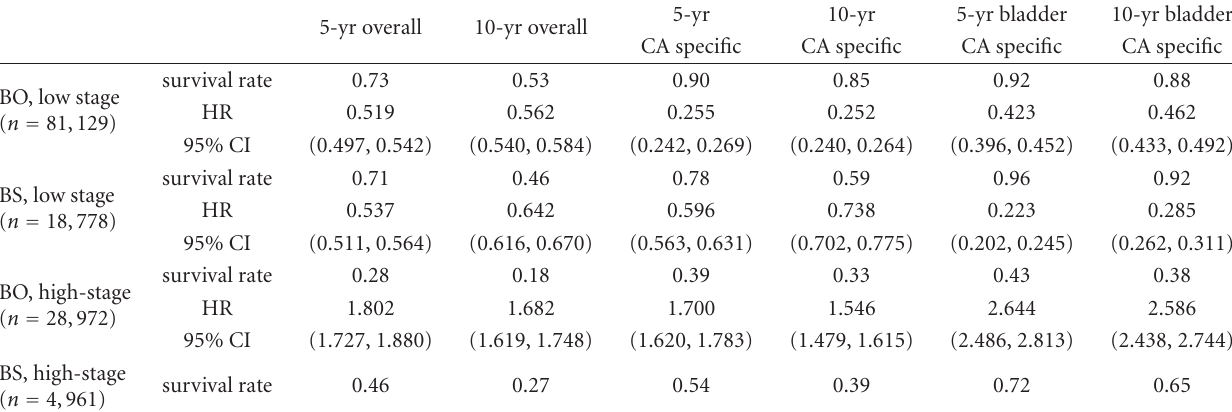
Figure 2: (a) Kaplan-Meier curves illustrate an overall survival advantage at 10 years for the high-stage BS cohort when compared to its respective high-stage bladder cancer only reference group. (b) The opposite finding existed for the low-stage patient groups, where the bladder cancer only patients had a slightly increased survival. Table 4: Stage adjusted survival rates and Cox hazard ratios for BO and BS cohorts, multivariate